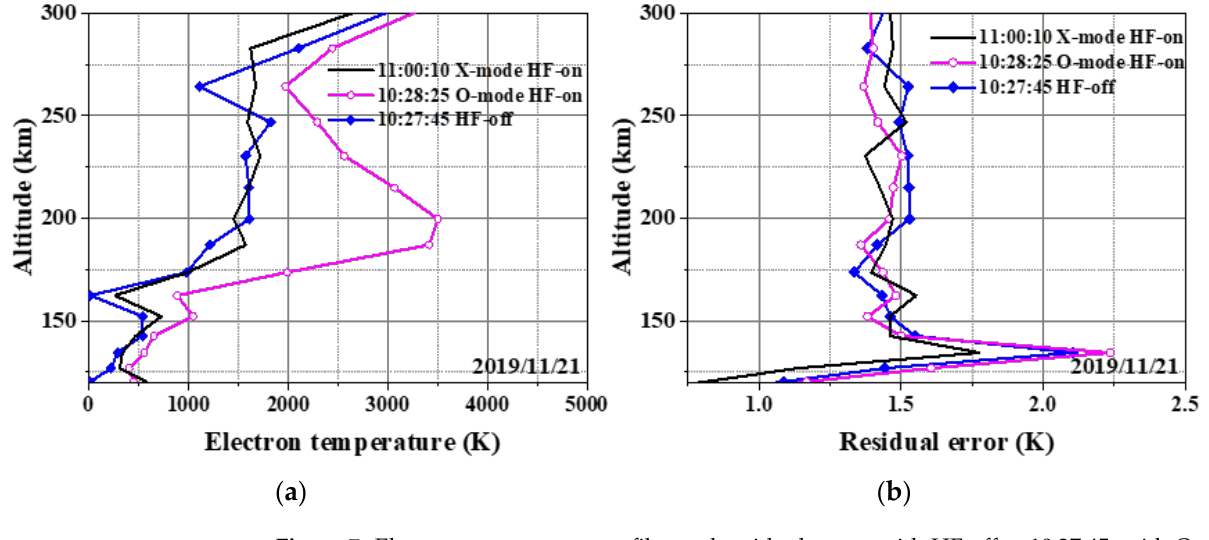
Figure 7. Electron temperature profiles and residual errors with HF-off at 10:27:45, with O-mode HF-on at 10:28:25, with and X-mode HF-on at 11:00:25.